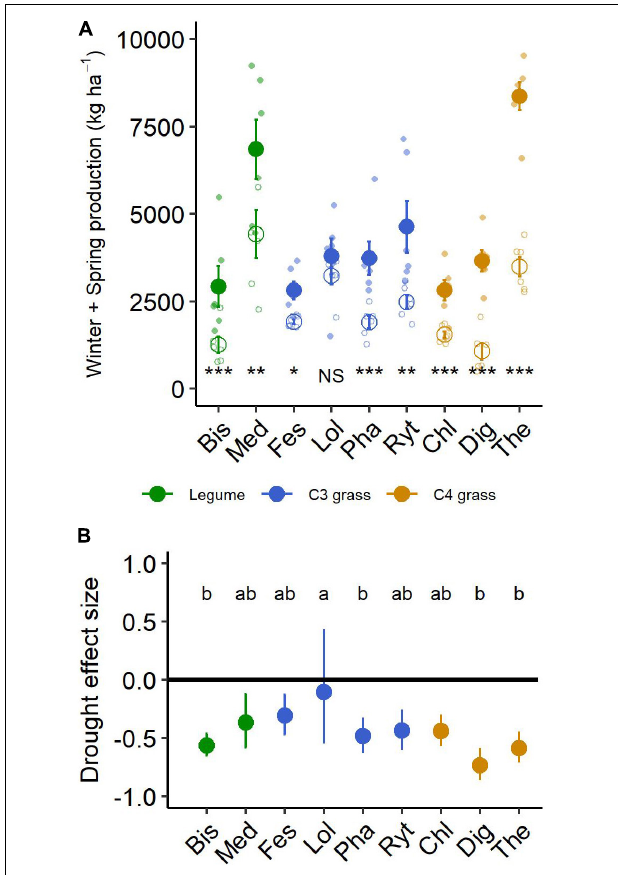
FIGURE 4 | (A) Aboveground production summed for all harvests during the 6-month winter/spring drought period. Large points shown are means ± 1 standard error (control = solid symbol, droughted = open symbol) and opaque points show species level variability in biomass. Significant pairwise comparisons for the effect of drought treatment are indicated as follows: NS, not significant, * P < 0.05, ** P = < 0.01, *** P = < 0.001. (B) Drought effect size (log response ratio of drought vs control production during the 6-month drought treatment period). Values for panel (B) are mean values with 95%